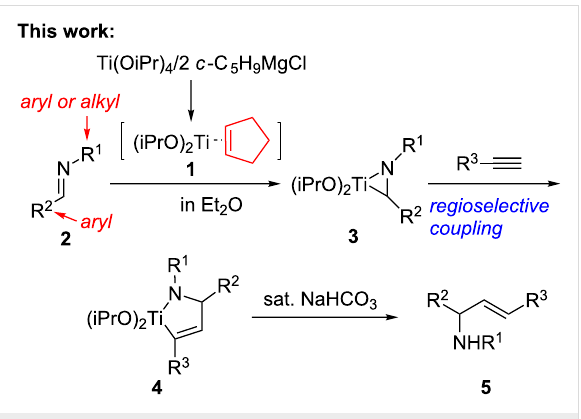
Scheme 1: Titanium-mediated cross-coupling of imines with terminal